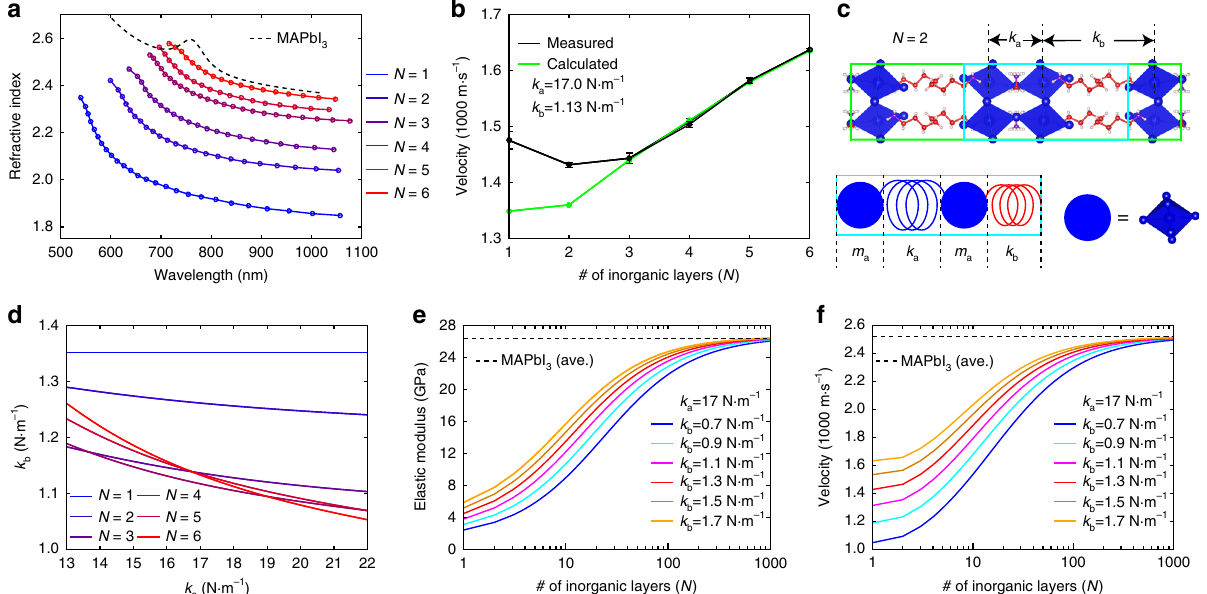
Fig. 4 The CLAP velocities of 2D RPs. a n ′ ( λ ) curves for N = 1 – 6 in the below-bandgap range, and n ′ ( λ ) for N = ∞ taken from literature. b Measured CLAP velocities plotted against N (number of inorganic layers), shown in black. Calculated results from the bead-spring model is shown in green. c Schematic illustration of the coarse-grained bead-spring model. In the upper fi gure, the green rectangle encloses a single unit cell, half of which, highlighted by a cyan rectangle, was considered in the bead-spring model, as illustrated in the lower fi gure. d The pairs of the spring constants that give the calculated velocities exactly matching the experimental ones for N = 1 – 6. Dependence of elastic modulus along the cross-plane direction in e and velocity in f on the number of inorganic layers plotted for various k b values (with k a fi xed at 17 N m − 1 ). Result for MAPbI 3 (average value of its lower and upper bounds) is shown in black dashed lines − 1 − 1 0.7% (averaged for N = 1 – 6), which con fi rms the accurate and 2990 m s , as discussed later). (ii) Decreasing N from 6 determination of n ′ ( λ ). Three interesting observations arise from to 2 causes a reduction of v , with the exception of v for N = 1 − 1 , Fig. 4b. (i) For N = 1 – 6, we fi nd v to be within 1430 – 1640 m s which falls in between that of N = 2 and N = 3. (iii) Varying N from which is signi fi cantly lower than that for N = ∞ (between 2340 m s 1 to 6, which lowers the weight percentage of the organic layer by